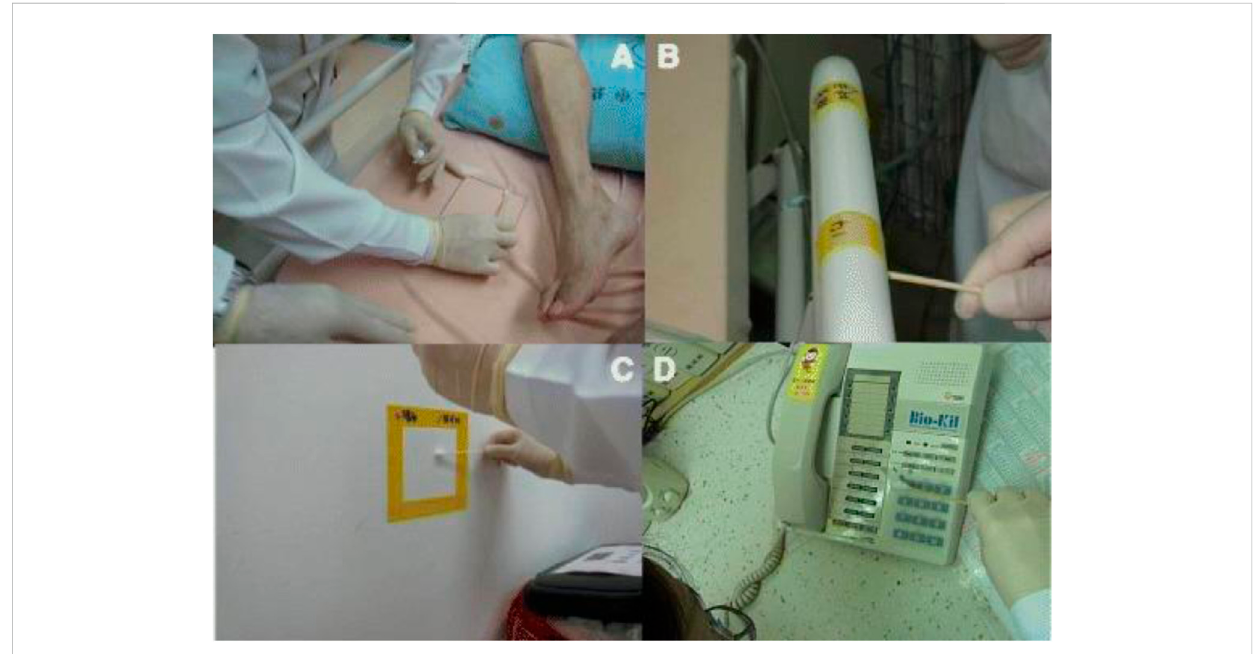
FIGURE 5 Bacterialculturesamplingbyswabbinga10 cm×10 cmsquareof (A) bedsheet, (B) bedrail, (C) atelephonekeypadandcementwallenclosedwitha Bio-Kil silicon pad. (D) A telephone keypad covered with a Bio-Kil silicon pad. Reproduced with permission from (Hsueh et al.,